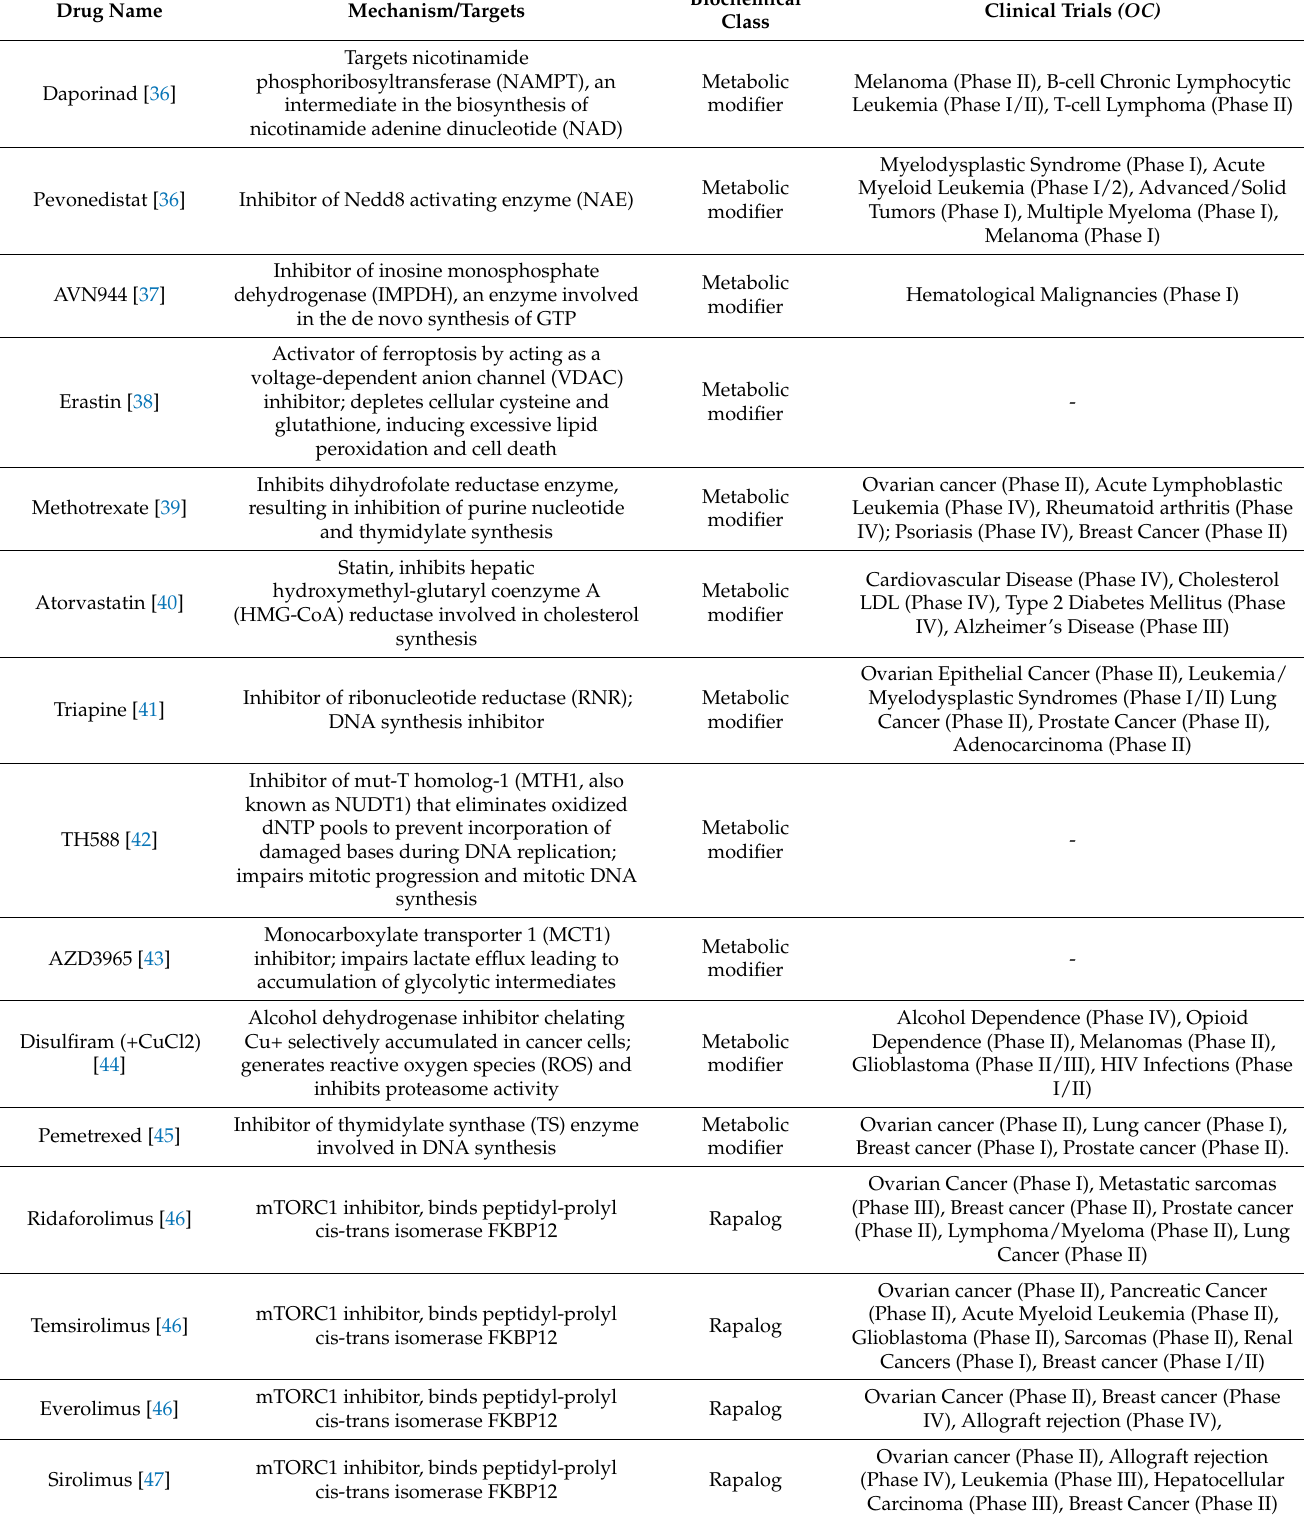
Table 2. Metabolic modifiers and mTOR inhibitors investigated in this study. Selected reference, biochemical class and main clinical trials are also listed. Clinical trial data is from DrugBank database